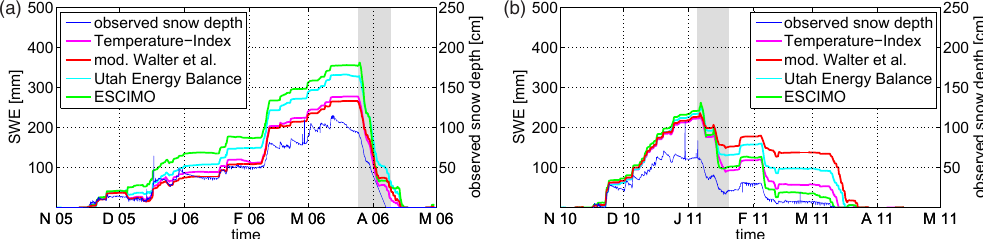
Figure 9. Comparison of simulated SWE and observed snow depth time series at the Torfhaus meteorological station: (a) winter season 2005–2006, (b) winter season 2010–2011. This plot includes time series of SWE for all tested snow models using downscaled WRF meteo- rological